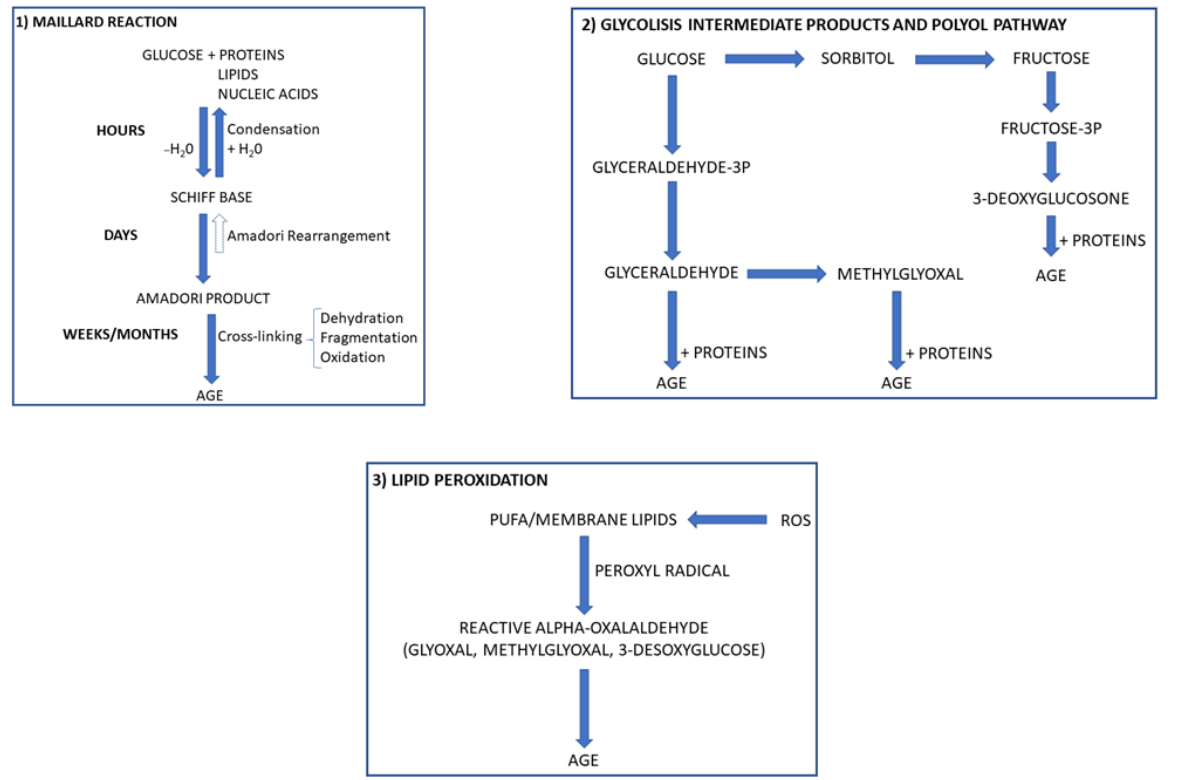
Figure 1. Biochemical reactions leading to advanced glycation end product (AGE) formation. Glucose may lead to AGE formation through the Maillard reaction ( 1 ) and the polyol pathway ( 2 ). This last mainly occurs in conditions of excessive glucose, which is converted into fructose. AGE can also be formed by reactive carbonyl species generated by lipid peroxidation in conditions of excessive oxidative stress and further reactions with nucleophilic residues of macromolecules ( 3 ). ROS, reactive oxygen species; PUFA, polyunsaturated fatty acids.